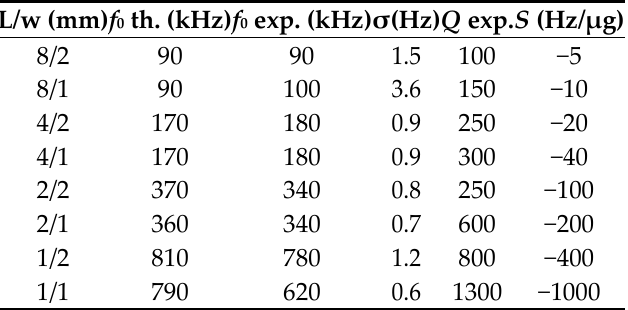
Figure 3. ( a ) Scheme of the test bench and ( b ) zoom on the microcantilever, whose largest area is perpendicular to the flow. Polystyrene powder (mean diameter = 2.5 µm) is used as airborne particles. Table 1. Theoretical ( f 0 th.) and experimental ( f 0 exp.) resonant frequencies, theoretical sensitivities ( S ), noise σ and quality factor Q exp.. The noise σ and the quality factor Q exp. are measured on one microcantilever for each dimension. f 0 exp. is the mean value obtained for each geometry. S calculations are made using f 0 exp. values. Refer to Appendix B for more